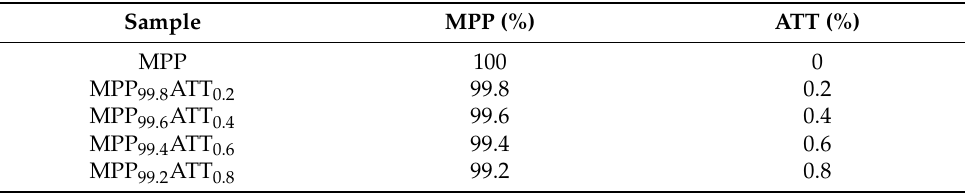
Figure 1. Diagram for the process of fabricating MPP/ATT nanocomposites. Table 1. Compositions of MPP and MPP/ATT nanocomposites.